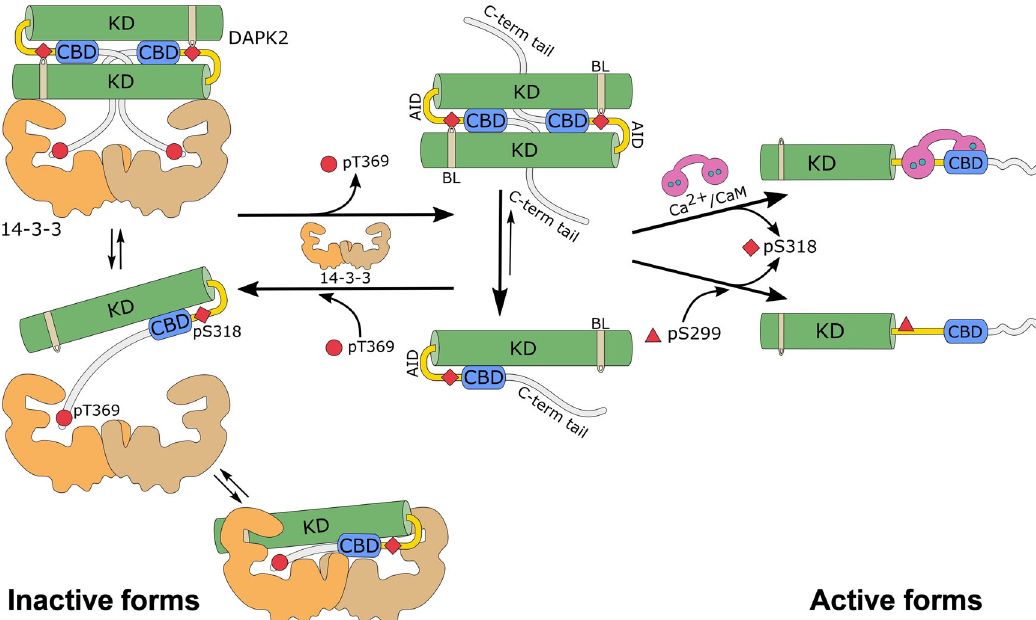
Fig. 7 DAPK2 inhibition depends on both autophosphorylation and interaction with the 14-3-3 protein. In solution, DAPK2 is in equilibrium between the cis -autoinhibited monomer or trans -autoinhibited dimer. Under physiological conditions, the equilibrium is shifted towards the monomeric form. In both cases, DAPK2 is locked in the autoinhibited conformation mediated by Ser 318 autophosphorylation (represented as a red diamond). The phosphorylation of the C-terminal Thr 369 (red circle), either by autophosphorylation or by PKB 26 (or some other still unidenti fi ed kinase), creates a mode III 14-3-3-binding site. Because the 14-3-3 dimer contains two binding grooves, 14-3-3 can increase the local DAPK2 concentration and shift the equilibrium towards the DAPK2 dimer. Accordingly, the inactive form of DAPK2 is a trans -autoinhibited dimer with autophosphorylated Ser 318 and Thr 369 in a complex with the 14- 3-3 dimer, which stabilizes the dimeric form of DAPK2, protects Ser 318 against dephosphorylation, and prevents Ca 2 + /CaM binding to DAPK2. Alternatively, 14-3-3 proteins interact with only one molecule of DAPK2, which could allow a bidentate interaction in which the 14-3-3 dimer simultaneously interacts with both the C-terminal motif and the pSer 318 -containing motif within AID. This bidentate interaction would also protect pSer 318 against dephosphorylation and destabilize Ca 2 + /CaM binding to DAPK2. In short, both Ca 2 + /CaM-dependent and -independent (based on Ser 299 phosphorylation 24 , represented as a red triangle) DAPK2 activation require Thr 369 and Ser 318